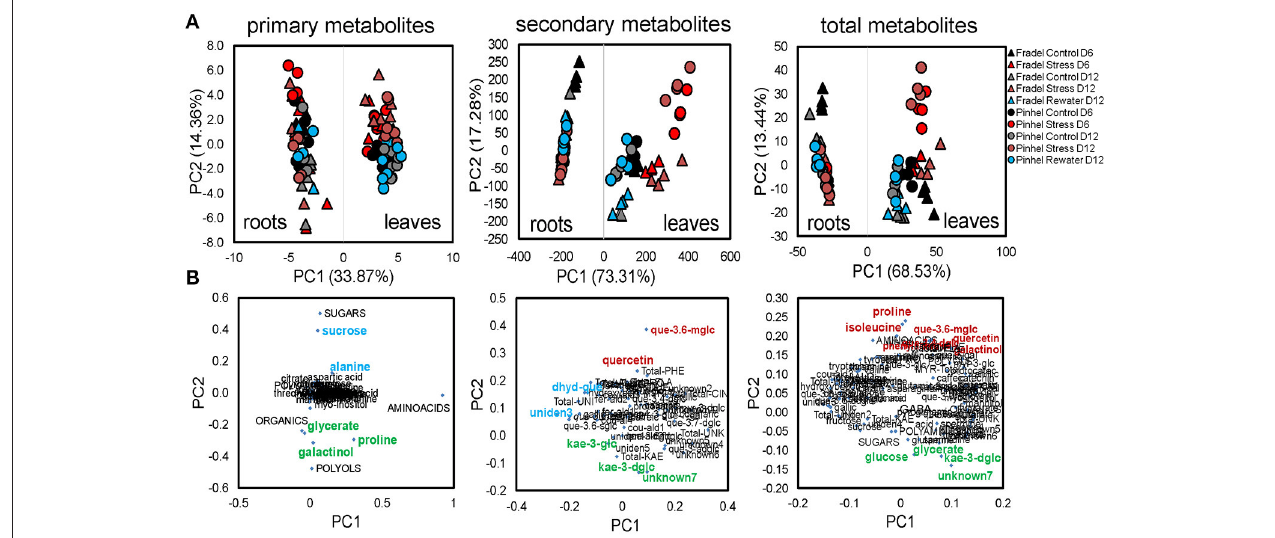
FIGURE 6 | PCA of metabolic differences among well-watered control, drought-stressed, and rewatered cowpea plants. Shown are 104 variables: 41 GC-MS primary metabolites + 5 categories, and 35 LC-DAD secondary and 12 unidentified metabolites + 11 categories ( n = 4–6). Data were square root-transformed with pareto scaling. (A) PCA scores with treatments as indicated in the legend. (B) Highest positive and negative loadings ( Supplementary Table 6 ) associated with metabolic responses to stress/rewatering are tagged in red and green, respectively. Loadings associated with other factors, e.g., sampling time, cultivar, or organ, are highlighted in blue. Metabolites were grouped according to functional categories, indicated in capital letters. The complete names of secondary metabolites can be retrieved from Supplementary Table 3 .